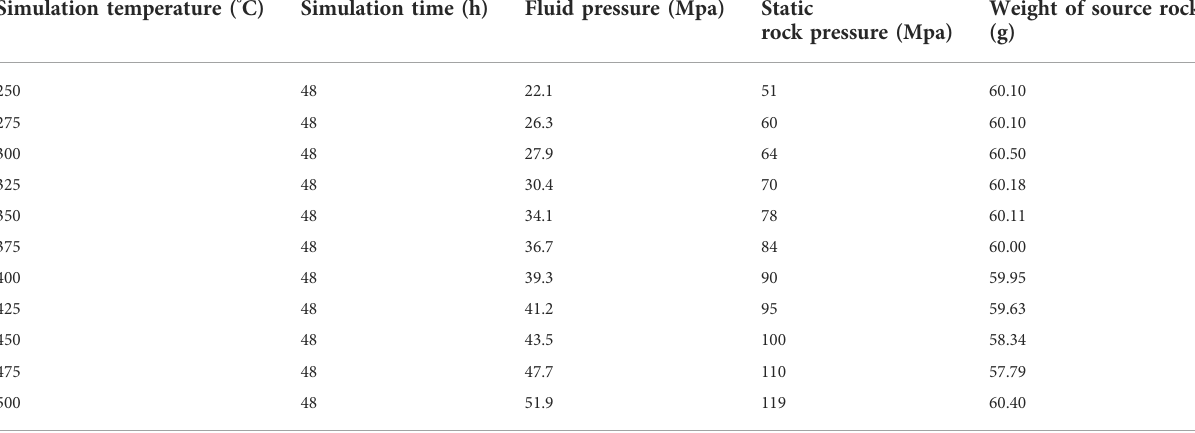
TABLE 2 Hydrocarbon generation and expulsion experiment program of source rock sample no. XY1-4L in the Yancheng Sag, Subei Basin. Simulation temperature ( °